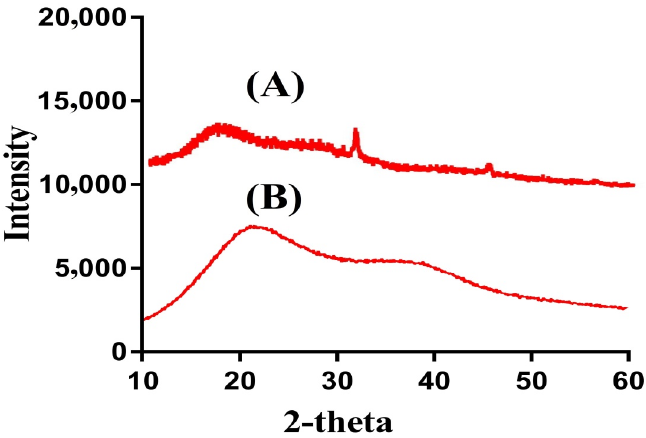
Figure 5. Powder X-ray diffraction (PXRD) of ( A ) SPS, ( B ) SPSPAA